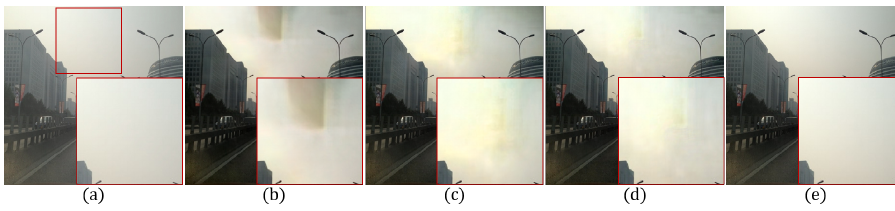
Figure 2. Effects of network structure: ( a ) hazy input image, ( b ) without residual blocks, ( c ) without gate block, ( d ) the proposed method, ( e ) the clean image.